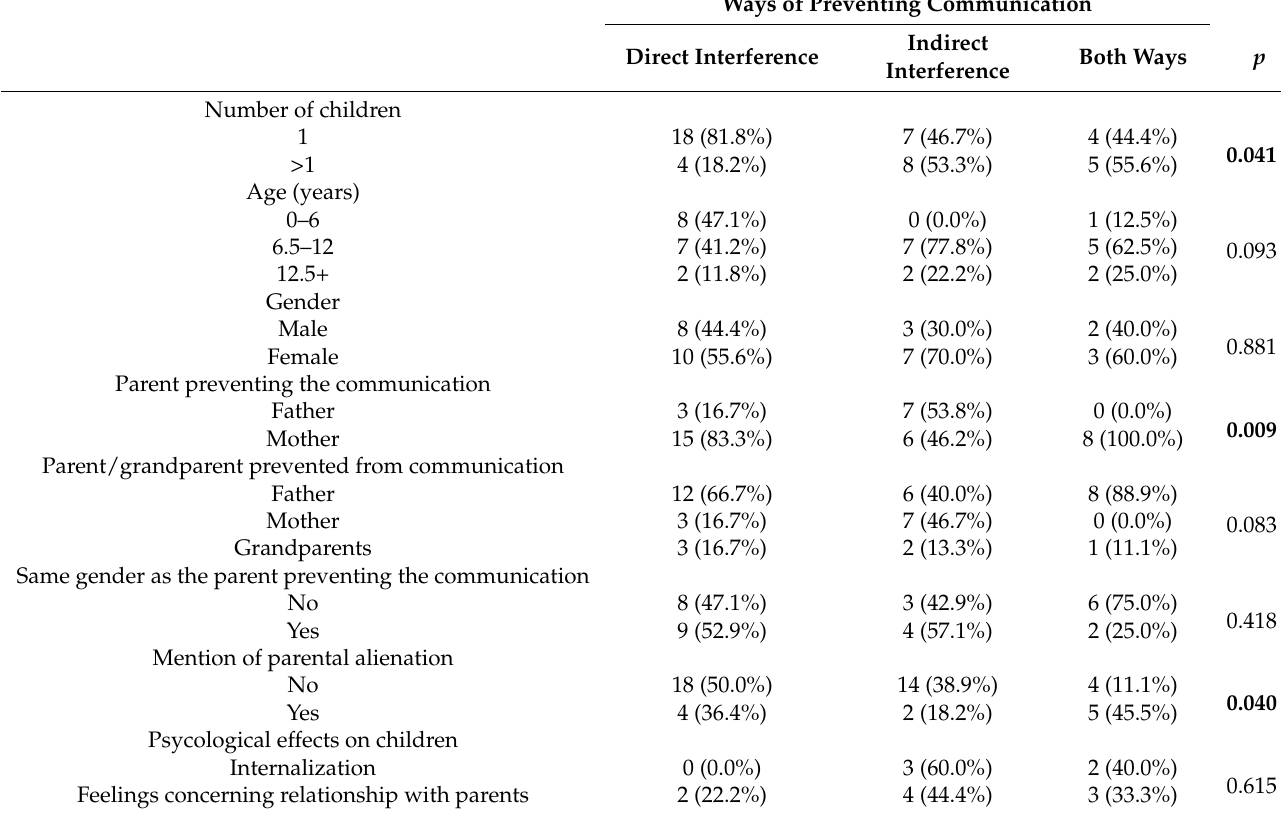
Table 1. Test of independence between ways of preventing communication and several demographic and other